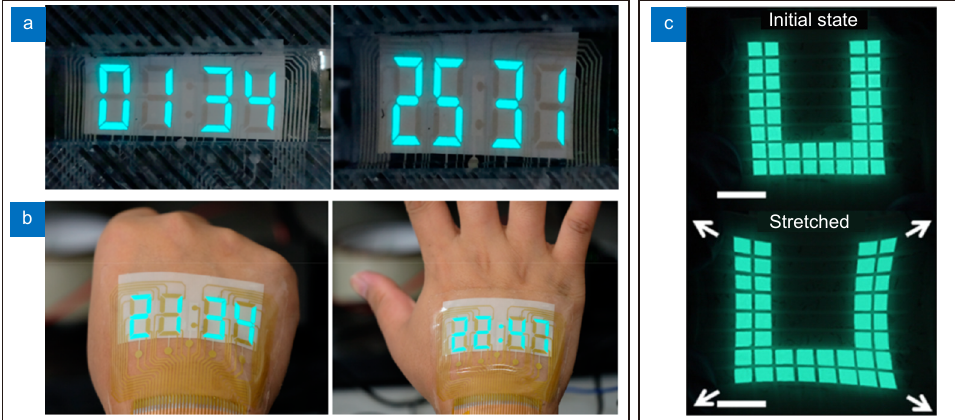
Fig. 11 | Intrinsically stretchable optoelectronic systems. ( a ) Photographs of an intrinsically stretchable alternating current EL display stably operating before and after stretching. ( b ) Photographs of the intrinsically stretchable display mounted on hand skin. ( c ) Photographs showing an intrinsically stretchable display being distorted by stretching. Figure reproduced with permission from: (a, b) ref. 62 , (c) ref. 182 , American Chemical